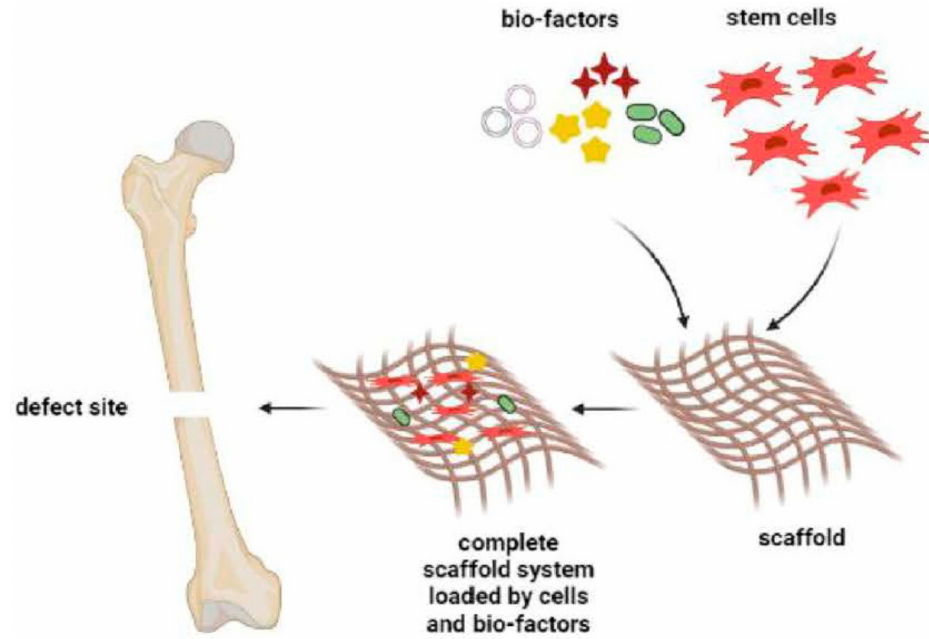
Figure 20. A tissue engineering approach for developing an advanced bone scaffold. Reprinted from Ref. [759] with